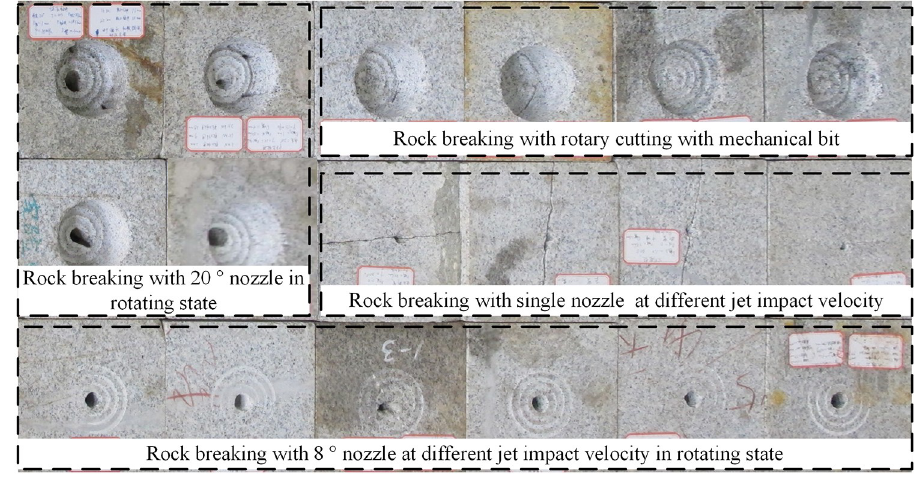
Fig 12. The rock broken samples and measurement